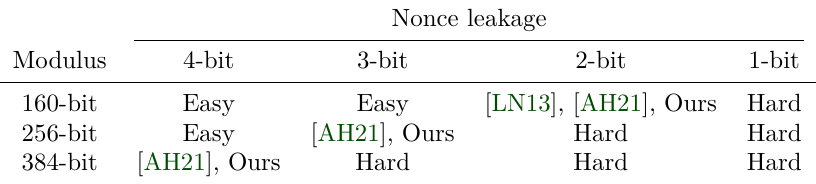
Table 1: Tractable parameters for lattice attacks on